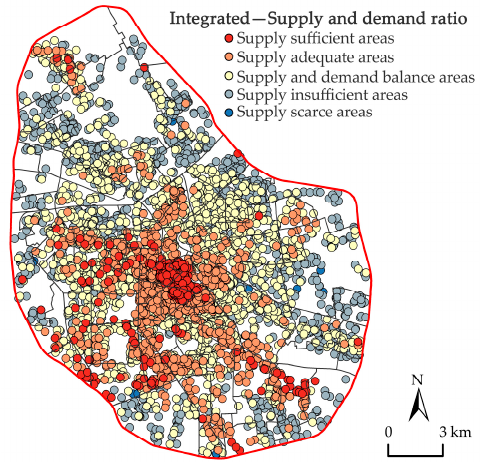
Figure 10. Schematic diagram of SDM assessment of comprehensive public health resources in the central urban area of Tianjin. Table 7. Hierarchical statistics of SDM of comprehensive public health resources in research area.